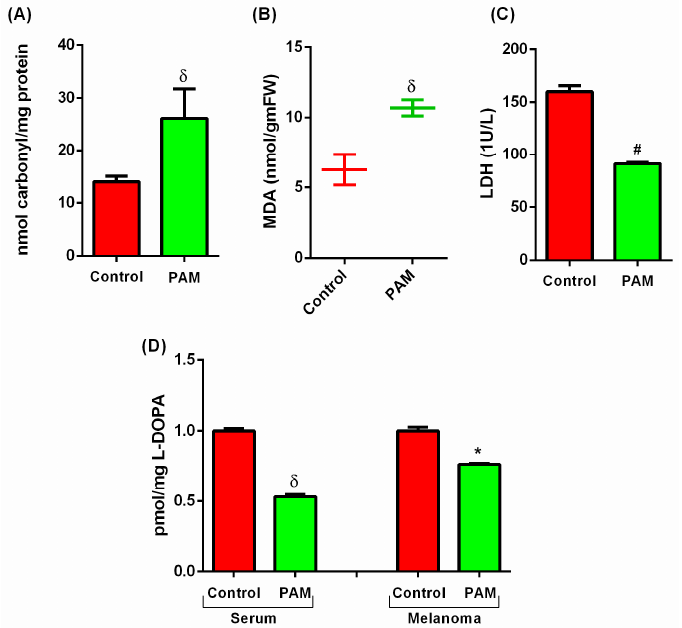
Figure 3. PAM induced oxidative damage and prognostic marker expressions in mice model; ( A ) protein carbonyl content estimation; ( B ) assessment of lipid peroxidation by the estimation of Malonedialdehyde (MDA) level; ( C ) lactate dehydrogenase (LDH) level, and ( D ) L-3,4-dihydroxyphenylalanine (L-DOPA) level. Blood serum and melanoma samples were collected on the 21st day of the experiment and stored at − 80 °C. Data are mean ± SD of the mean, n = 3. * p < 0.05; δ p < 0.01, # p < 0.001.